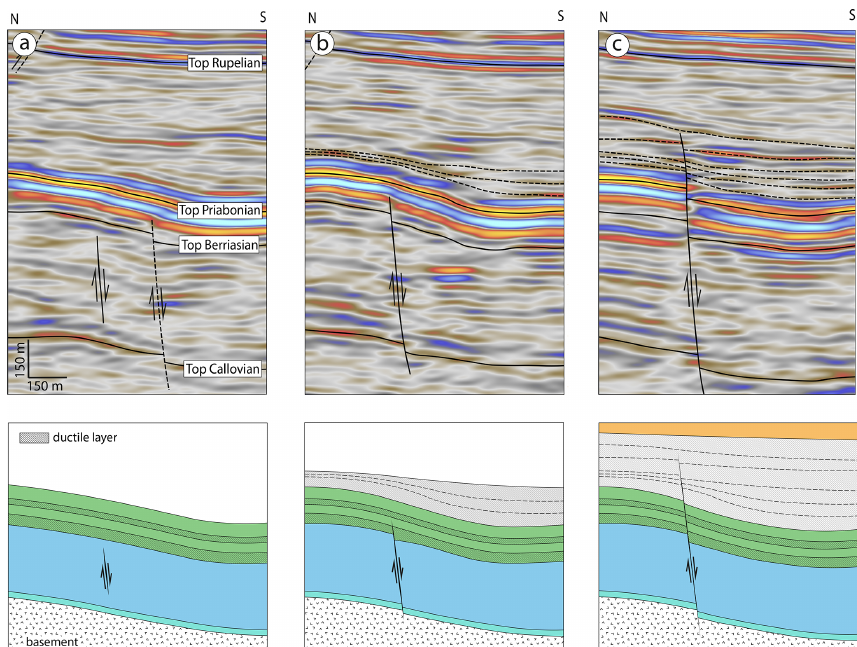
Figure 10. Stages of lower fault evolution based on the example of NE Fault: (a) nucleation of the NE Fault within the carbonate platform; (b) up-dip propagation of the fault inhibited by multi-layered stratigraphy. Overlying units are forced to flex; (c) eventually, the fault breaches the monocline. The stagnant fault tip is buried by the later Rupelian